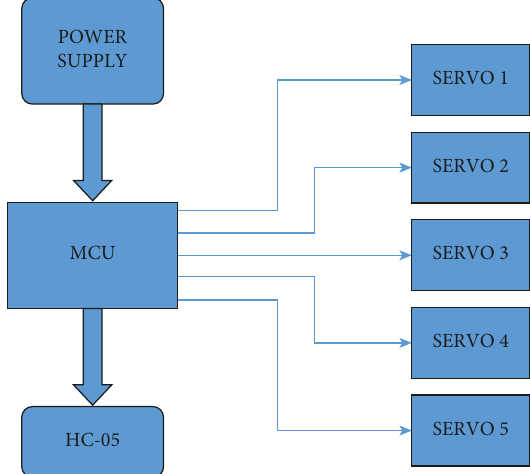
Figure 2: Block diagram of microcontroller in the slave